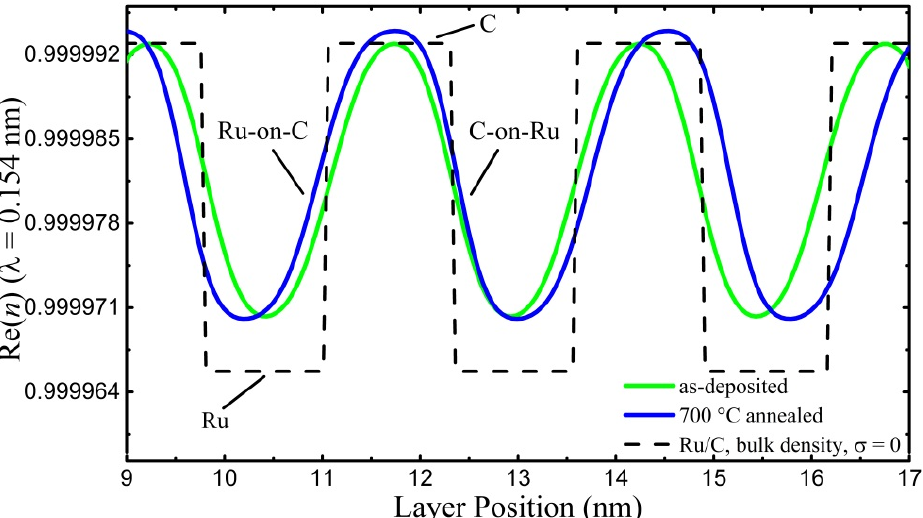
Figure 3. Real part of refractive index profile of the as-deposited and 700 °C annealed Ru/C multilayers with ideal layer structure (dashed lines) and experimentally fabricated structure (solid lines). Bulk densities of Ru and C are 12.3 and 2.2 g/cm 3 , respectively.